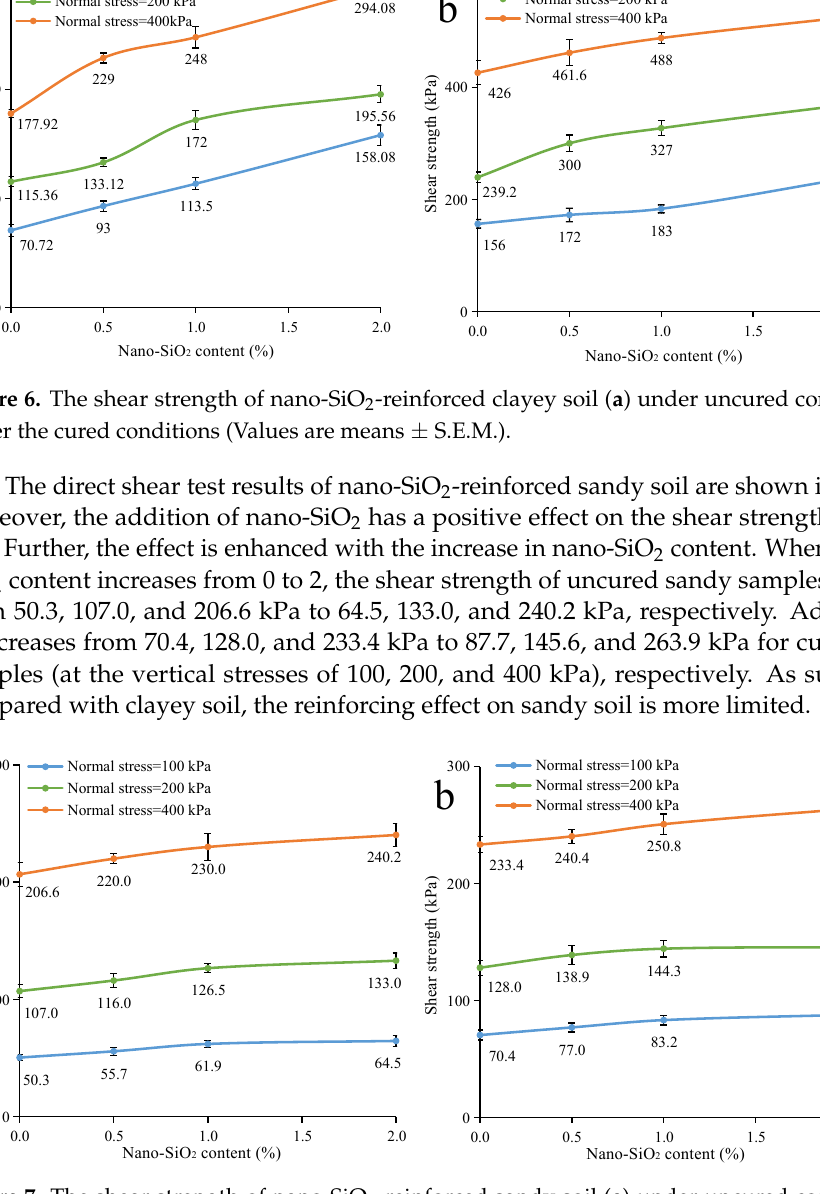
Figure 7. The shear strength of nano-SiO 2 -reinforced sandy soil ( a ) under uncured conditions ( b ) under cured conditions ( Values are means ± S.E.M.).